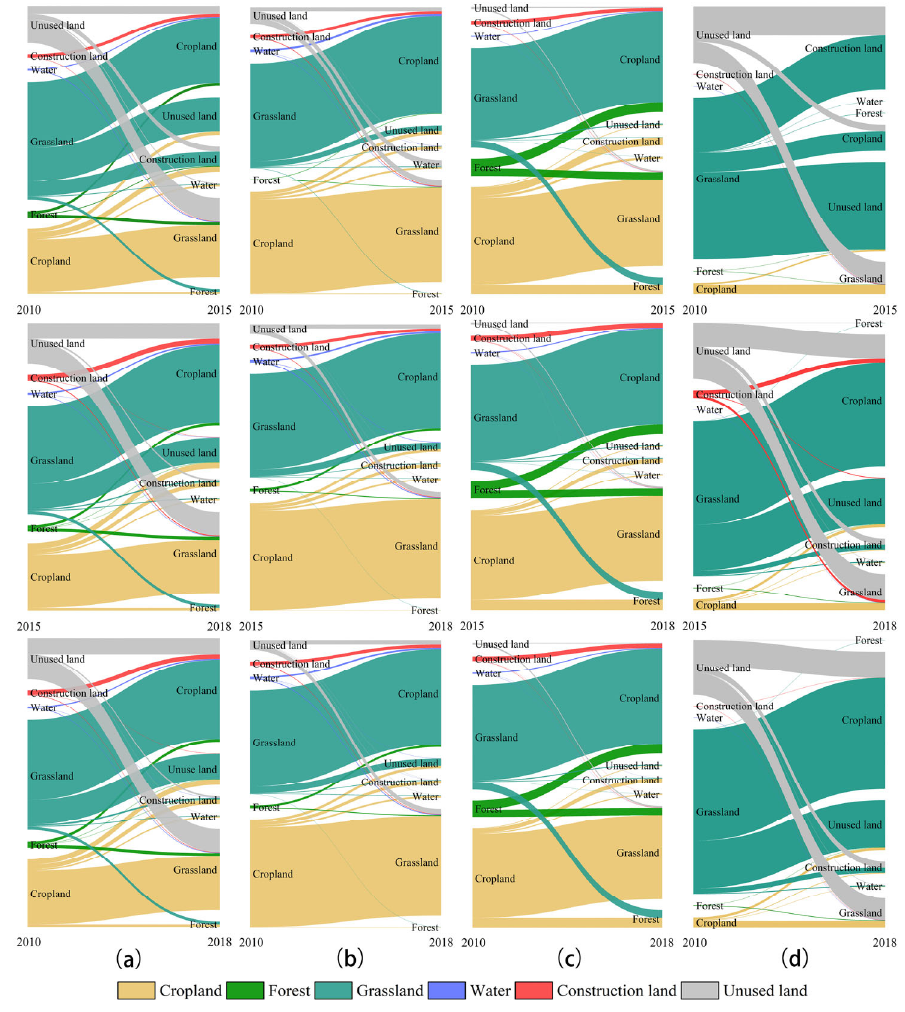
Figure 6. Land use transfer in different regions, 2010–2018: ( a ) Gulang; ( b ) WTM; ( c ) WVM; ( d ) MS.